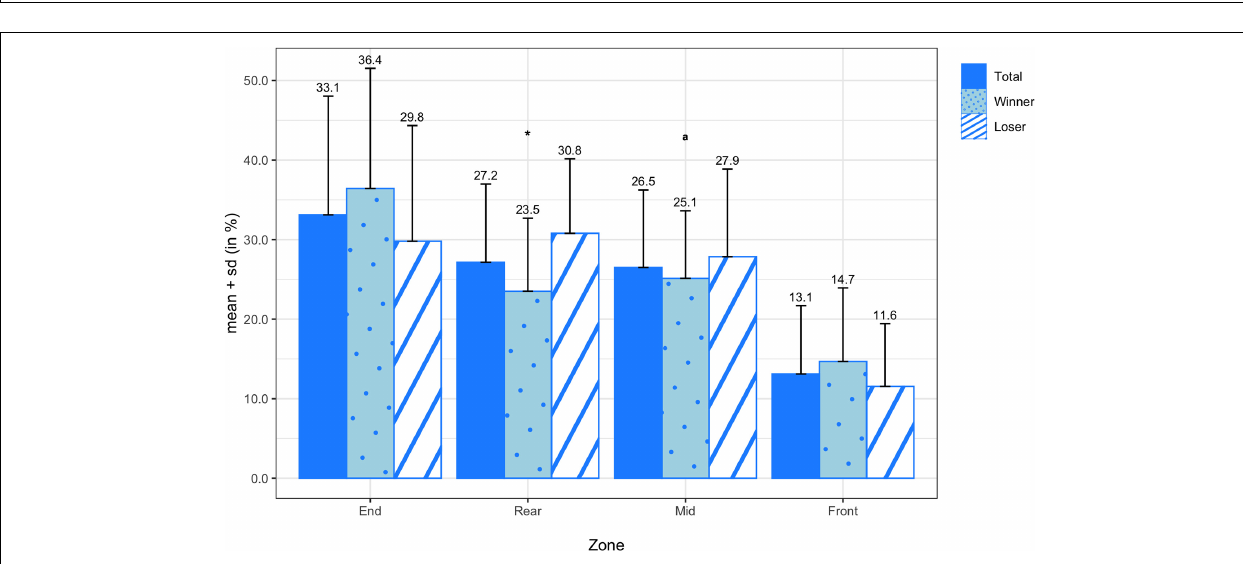
FIGURE 6 | Transition probabilities of earned turnovers by zone for all teams, winning teams, and losing teams. * denotes a significant difference between winning and losing teams at a significance level of 0.05. Variables compared using a non-parametric test are marked with an a